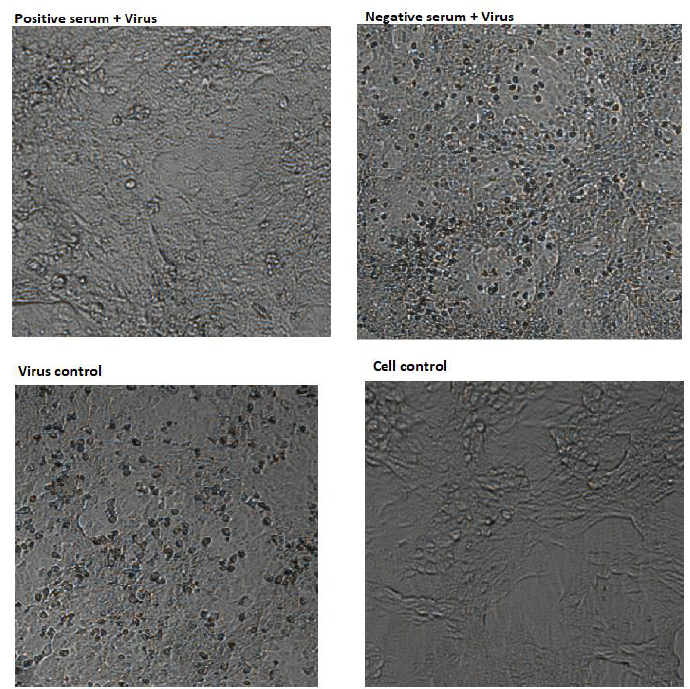
Figure 4. A neutralization test was conducted to evaluate the ability of a ZIKV-specific antibodies to prevent cpe. Cells infected with ZIKV pre-incubated with sera from immunized mice showed no CPA (positive serum + virus). Cytopathic effect (CPE) was seen in serum without ZIKV specific antibodies (Negative serum + Virus), comparable to cultures infected only with ZIKV (Virus control). The panel “Cell control” shows uninfected cells.